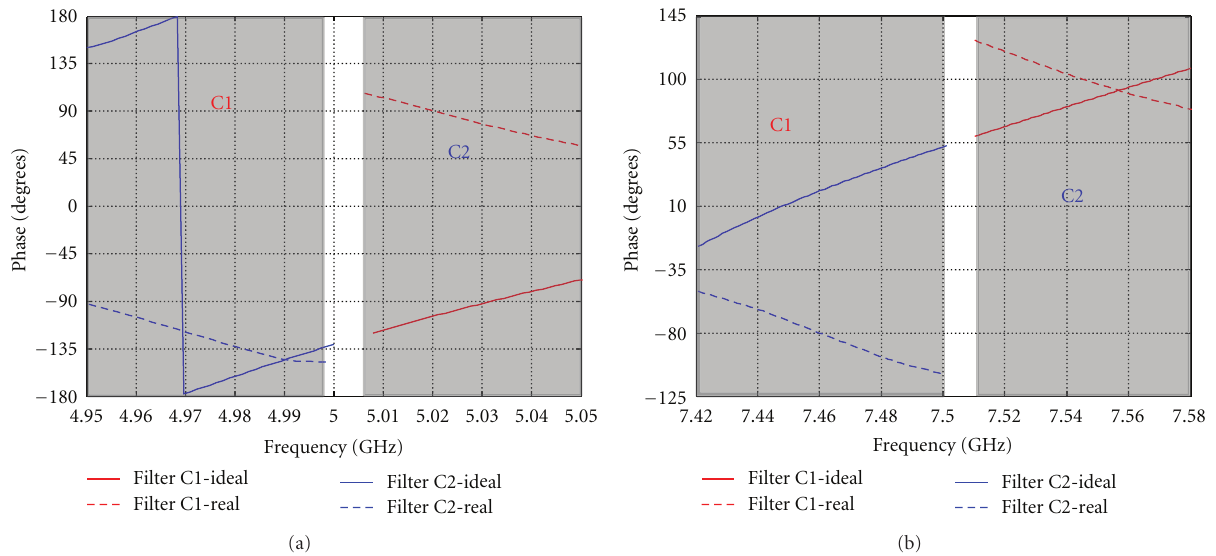
Figure 15: Out-of-band S22 phases profile of real filters, compared to the ones of ideal filters at f L (a) and f H (b).